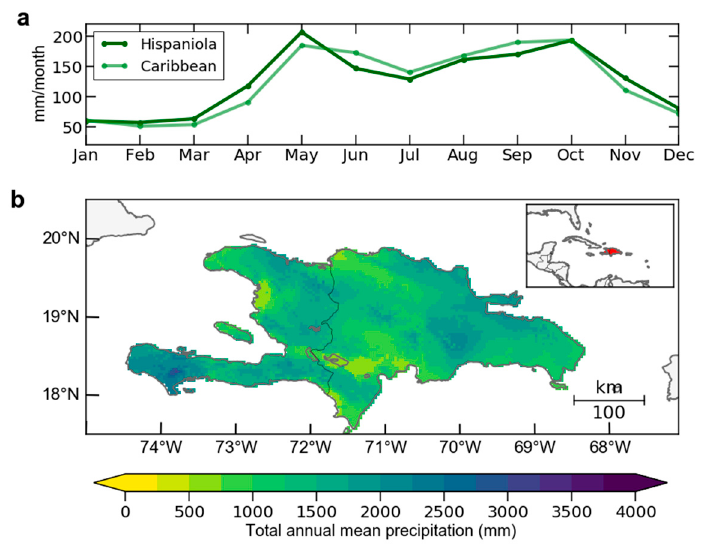
Figure 1. Observed precipitation climatology over Hispaniola Island: ( a ) Annual precipitation cycle of Hispaniola Island and the Caribbean for the 1950–2015 period, showing the two maximums (April–May and August–October), the minimum (November–March), and the mid-summer drought (June–July). ( b ) Total annual mean precipitation of Hispaniola Island showing spatial distribution in rainfall across the island. It is noticeable that there is a heterogeneous spatial distribution of precipitation, which is related with local topography. The data source comes from Herrera and Ault (2017) [3].